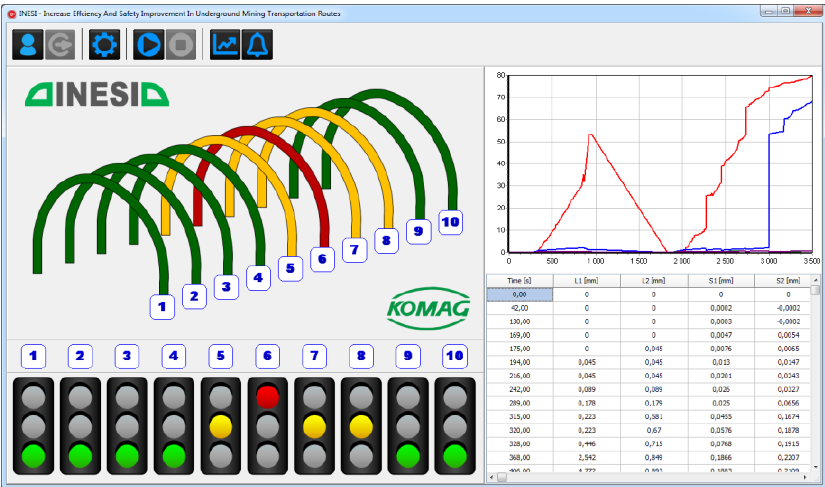
Figure 9. Main window of software supporting the hardware module.